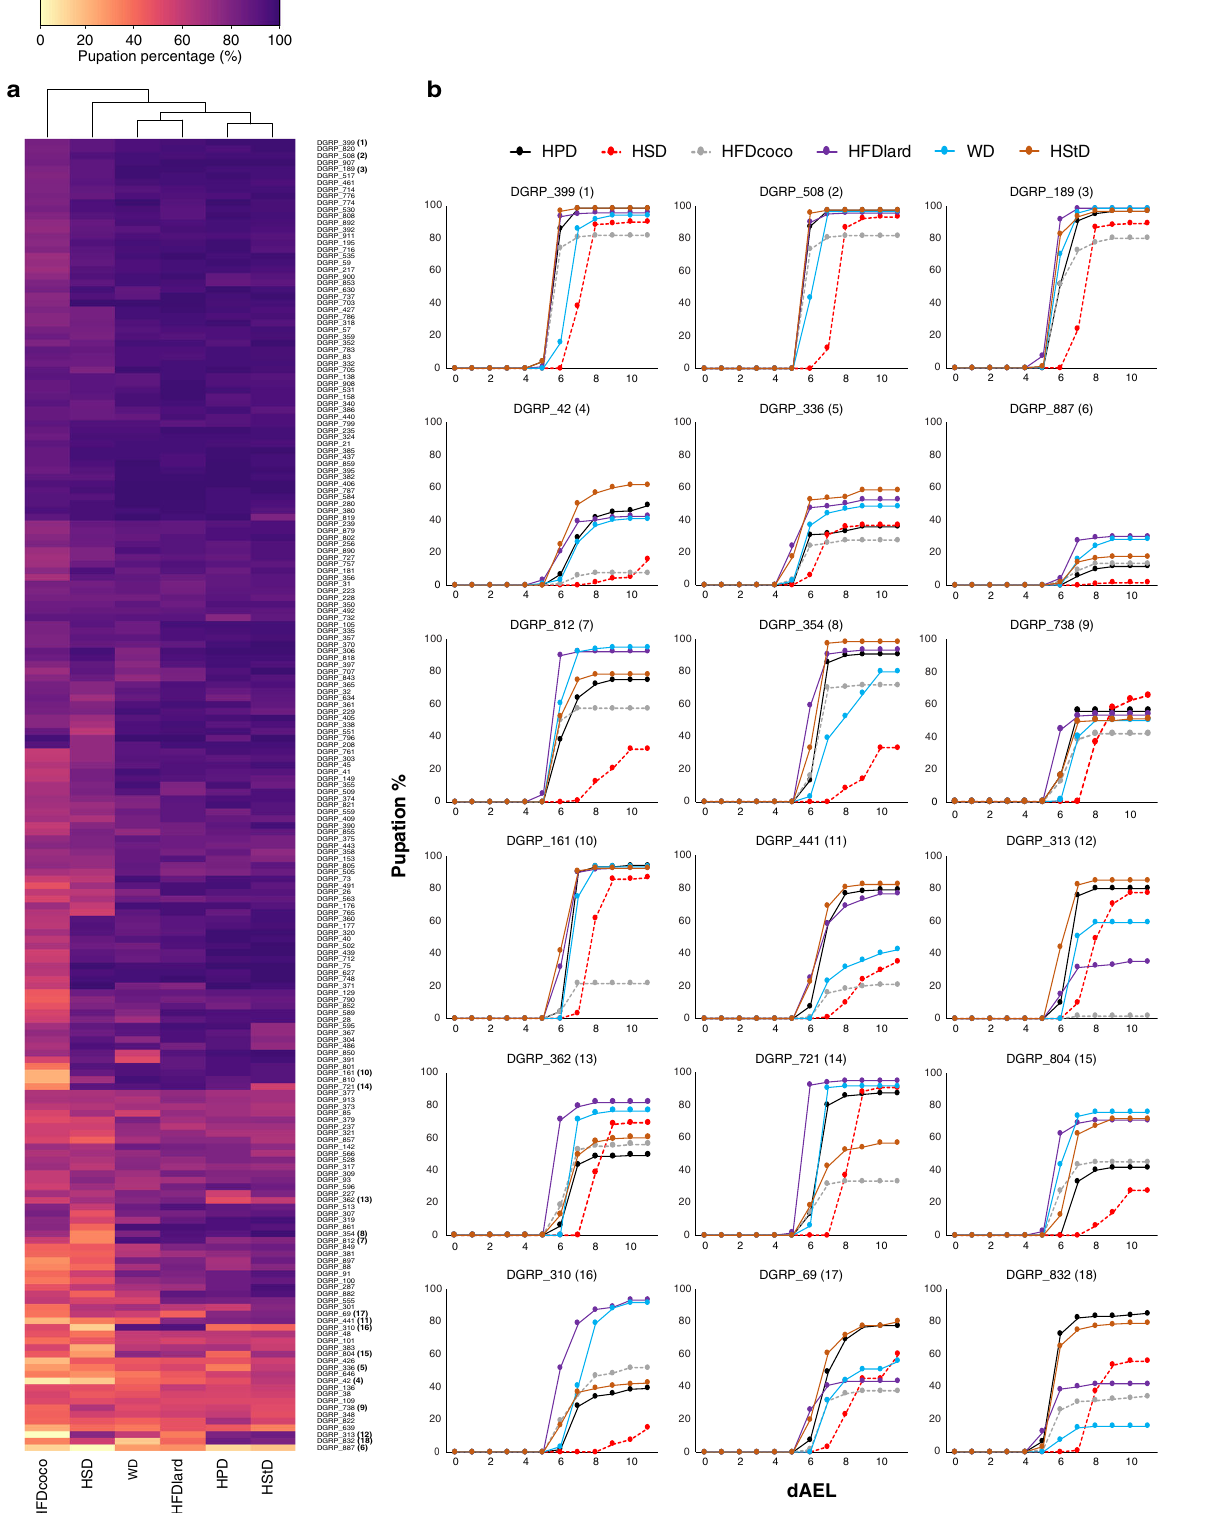
Fig. 2 Diet-dependent survival of DGRP strains into pupae. a A heatmap showing the survival of the 196 DGRP strains into pupal stage across six different diets. b Pupation kinetics of selected DGRP strains. The numbers after DGRP strain IDs correspond to the ones indicated in the heatmap, n = 4 vials (each with 30 larvae) per diet and genotype. dAEL = days after egg laying. Source data are provided as a Source Data fi le.